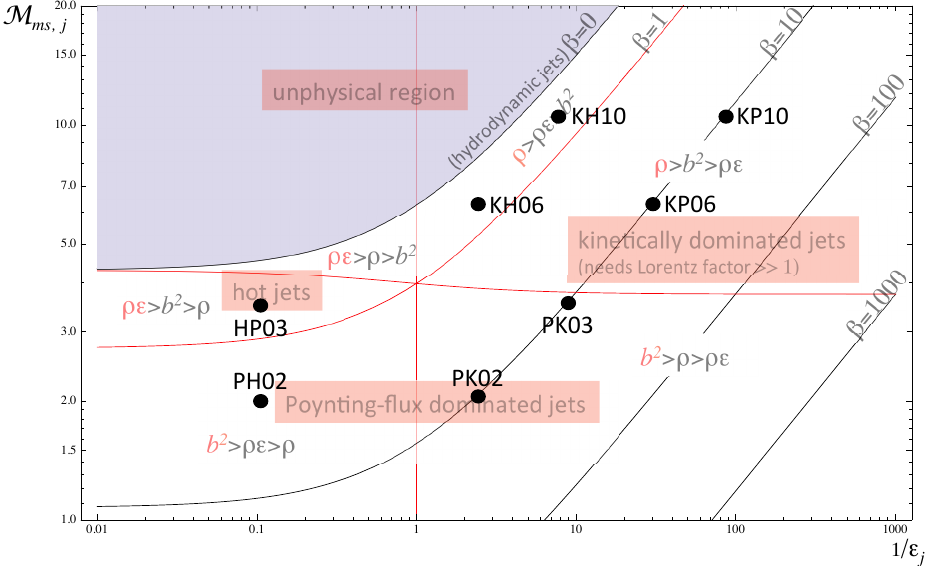
Figure 3. Jet classes in the M ms , j − 1/ ε j plane according to the dominant energy type, for given jet flow velocity, v j = 0.95. Drawn are lines of constant magnetization (0, 1, 10, 100, 1000). Kinetically-dominated jets, Poynting-flux-dominated jets, and hot jets are placed in the diagram with the help of three (red) lines, corresponding to models with ρ j = ρ j ε j , b 2 hydrodynamic models are placed on the β j = 0 line, which bounds a forbidden region (in violet) corresponding to unphysical models with negative magnetic energies. Superimposed: Distribution on the M ms , j − 1/ ε j diagram of the models considered in this